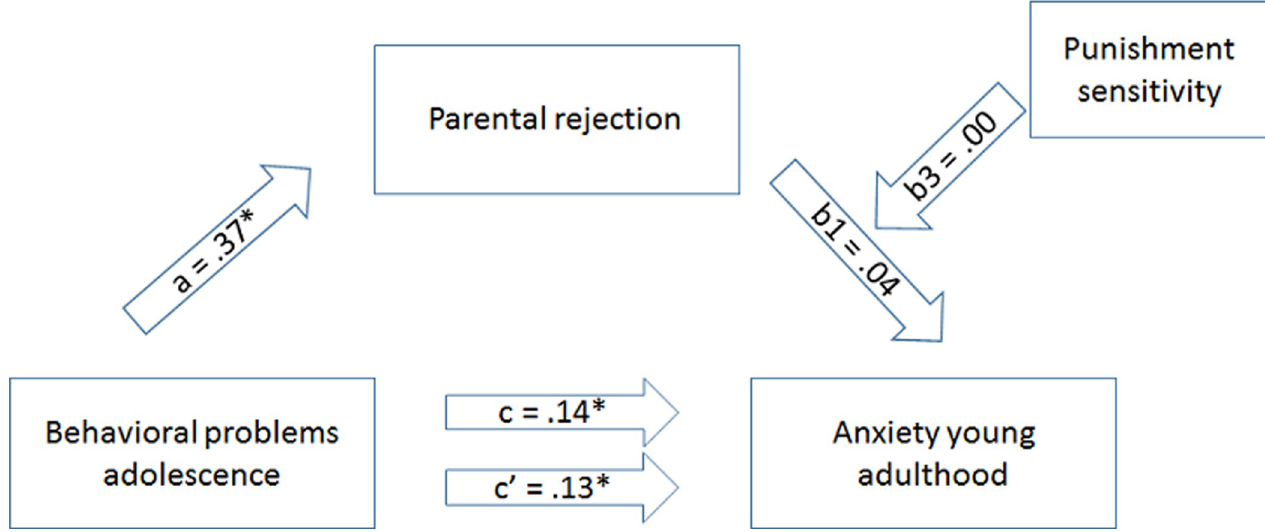
Fig 2. Moderated mediation model. Post-hoc analysis: moderation analysis.